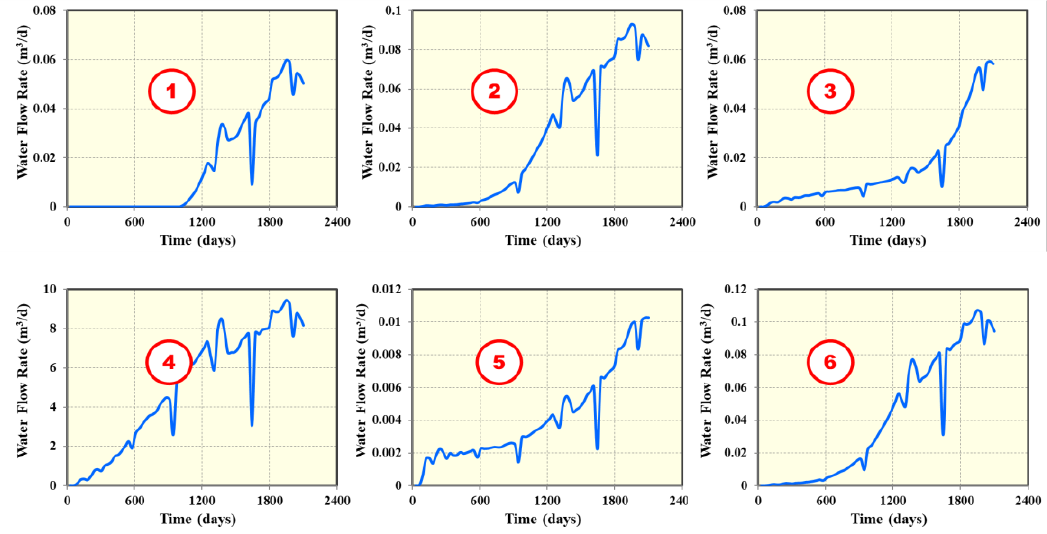
Figure 28. Different water intrusion responses from six different paths to well B2.